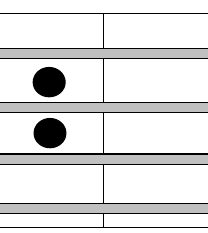
Figure 13. Application of the